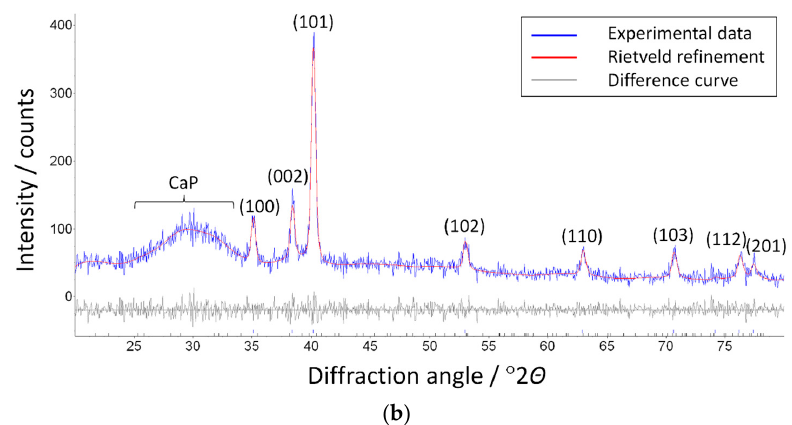
Figure 9. Representative X-ray powder diffractograms (with Rietveld refinement) of CaP coatings deposited on the Ti substrate perpendicular to the flux at 0° ( a ) and inclined at 80° ( b ). The diffraction peaks of HA and Ti (with Miller indices) are shown.